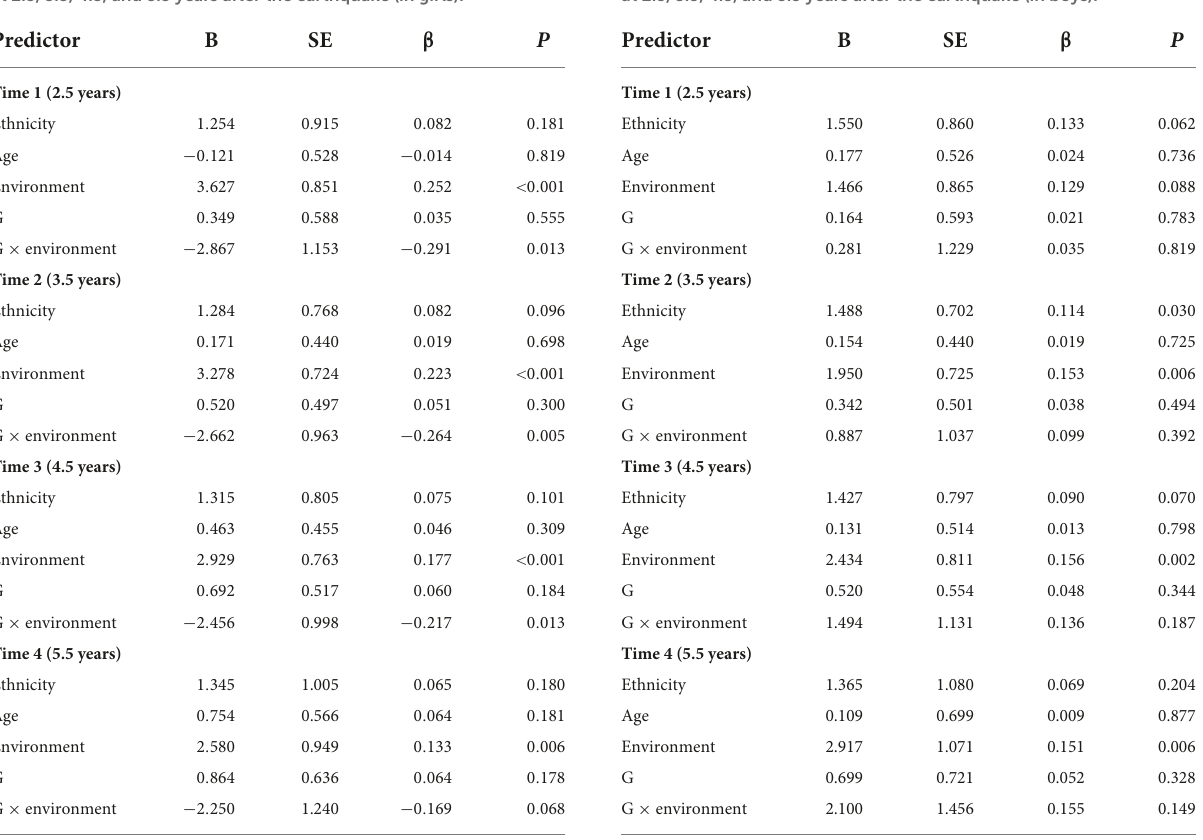
TABLE 7 Main and gene–environment interaction effects of rs2267735 on the course of posttraumatic stress disorder symptoms at 2.5, 3.5, 4.5, and 5.5 years after the earthquake (in